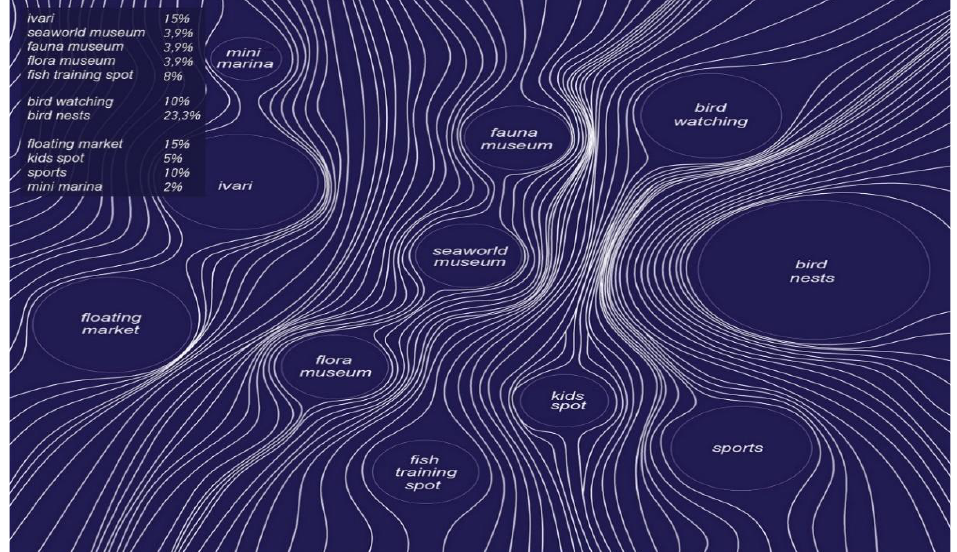
Figure 15. Eleni Kanellopoulou with Karolos Galanos (supervisor), 2022, Urban Safari 38.83, 20.70, Department of Architecture, University of Ioannina. Soft programmatic development. Reproduced with the permission of Kanellopoulou.